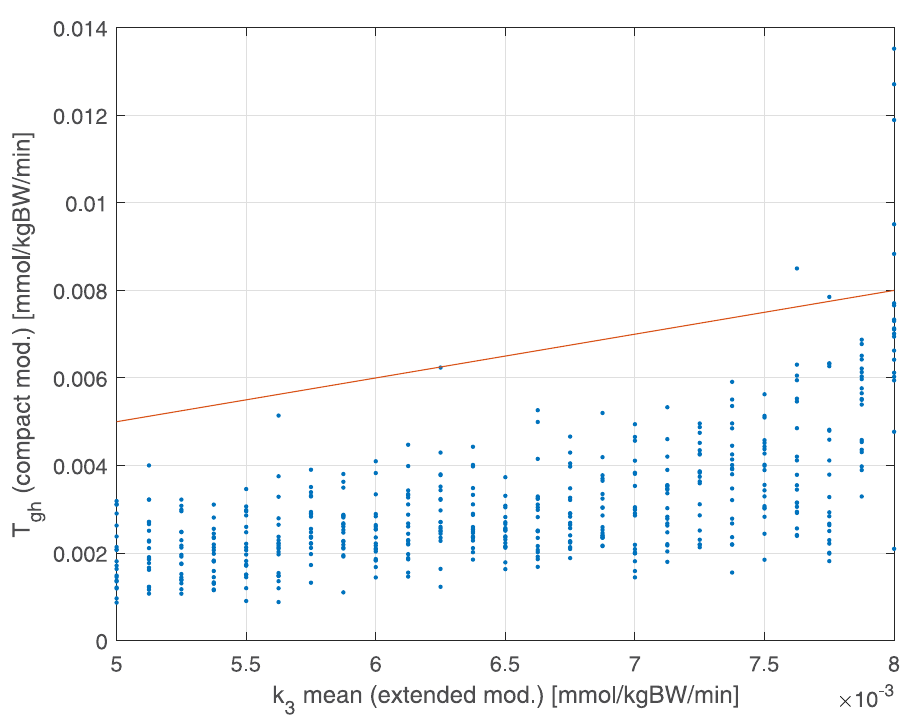
Fig 9. Dependence of estimated glucose net balance T gh from the generating � k the bisector T ¼ � k . Coefficient of correlation and its associated P-value: r = 0.62 ( P < 0.001). 3 gh